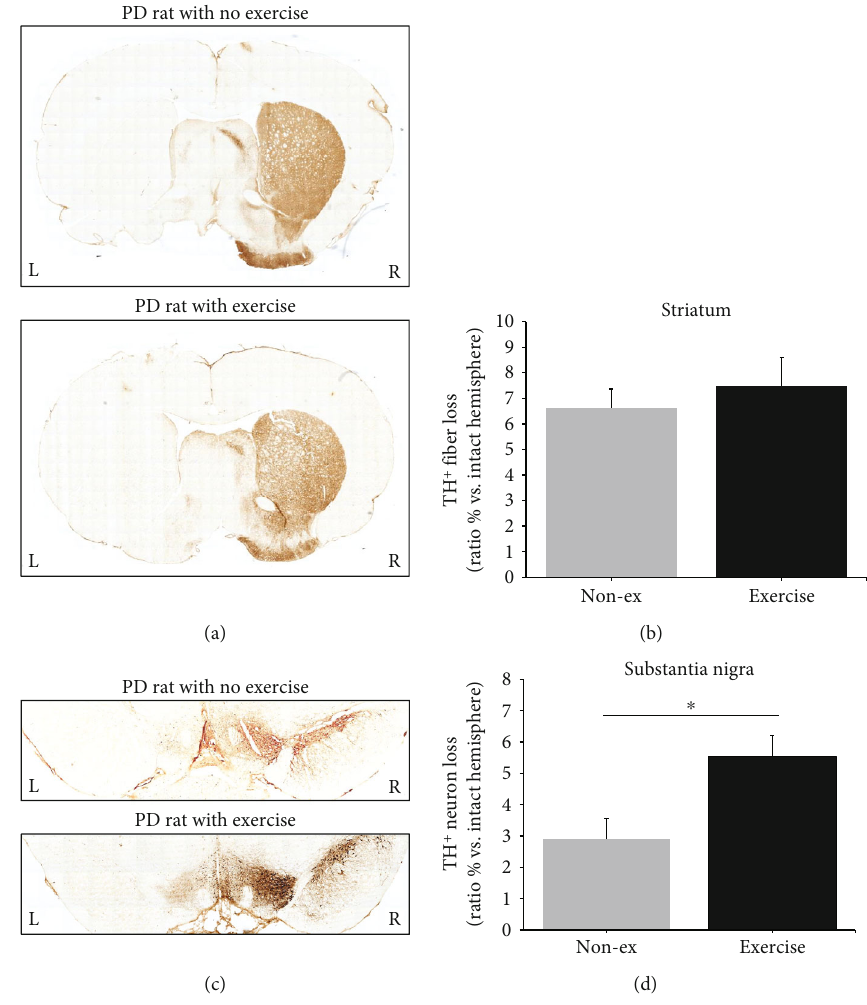
Figure 5: Representative tyrosine hydroxylase (TH) immunostaining in the striatum (a) and substantia nigra (c) in one nonexercise rat and one exercise rat 8 weeks post-PD lesion. No signi fi cant di ff erence was observed in TH immunoreactivity in the striatum (b). However, a signi fi cant di ff erence in TH immunoreactivity in the substantia nigra was observed between the nonexercise and exercise groups 8 weeks post-PD lesion. ∗ p < 0 : 05